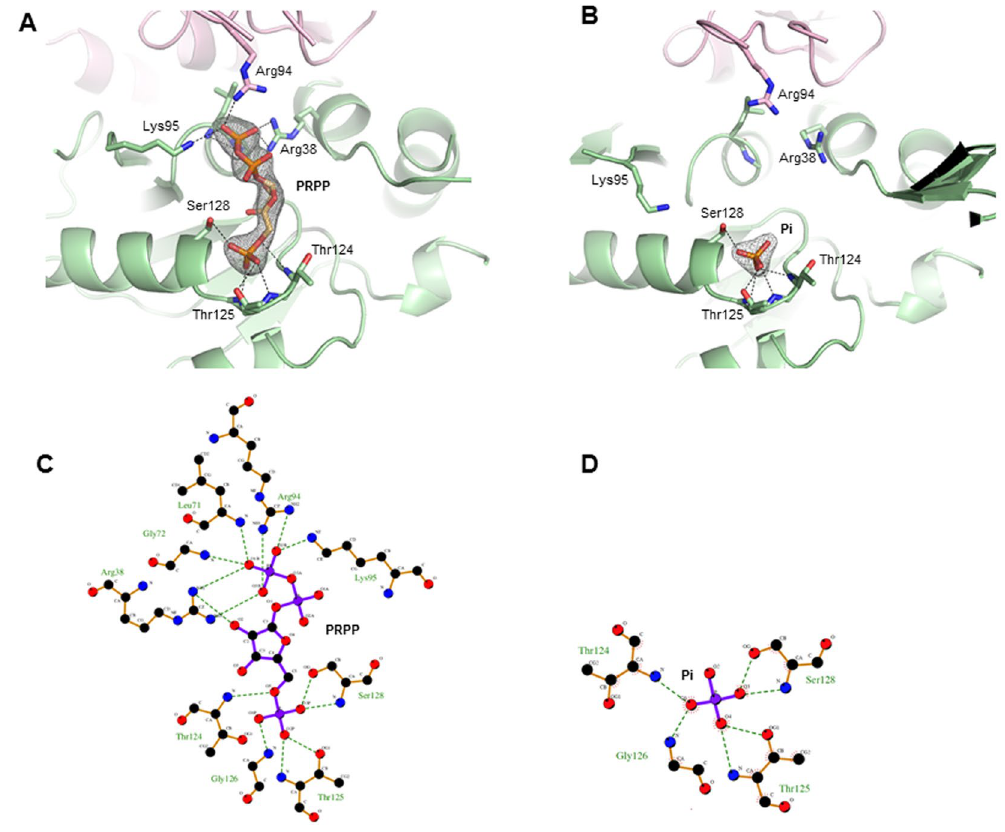
Figure 3. The active site of M. tuberculosis OPRTase in complex with PRPP (left hand side; (CC = 0.89) and Pi (right hand side; (CC = 0.97). ( A ) and ( B ) : σ A -weighted 2Fo-Fc electron density map contoured at 1.2 σ with residues involved in ligand binding depicted as sticks. ( C ) and ( D ) : schematic diagrams of the PRPP and Pi binding site. The interactions between ligands and residues within the active site are indicated by dashed black